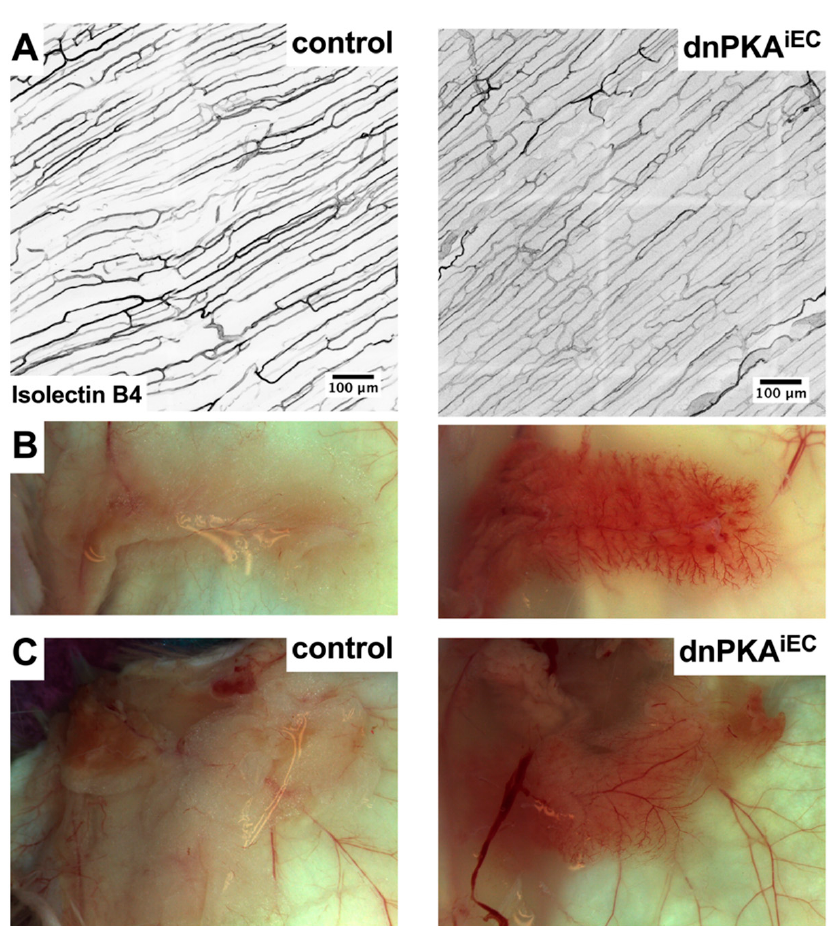
Figure 2. Inhibition of endothelial PKA leads to tissue-specific hypersprouting. ( A ), Isolectin B4 staining of blood vessels in dorsal skin of control (Tg( Cdh5-cre/ERT2 ) 1Rha without floxed transgenes) and dnPKA iEC mice demonstrates no differences in morphology or density of cutaneous vessels. ( B , C ), Inguinal ( B ) and thoracic ( C ) fat pads of dnPKA iEC mice (both in males and females) had much